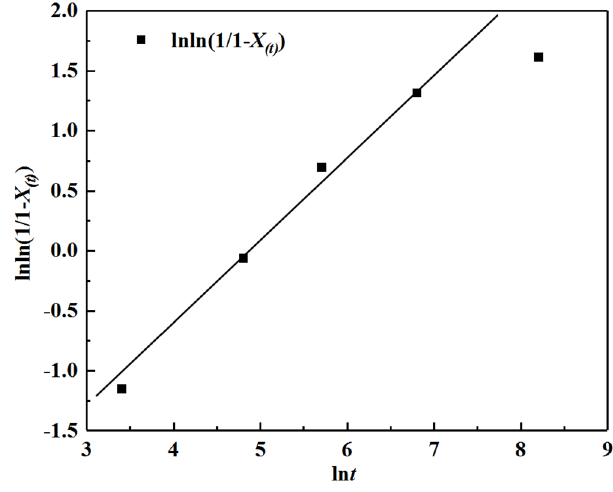
Figure 21. The linear relationship between lnt and lnln(1/1 − X (t) ) .